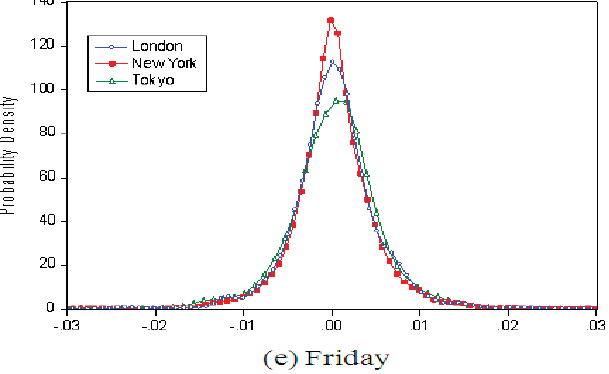
Fig. 5. Probability distributions of gold returns from Monday to Friday in London, New York, and